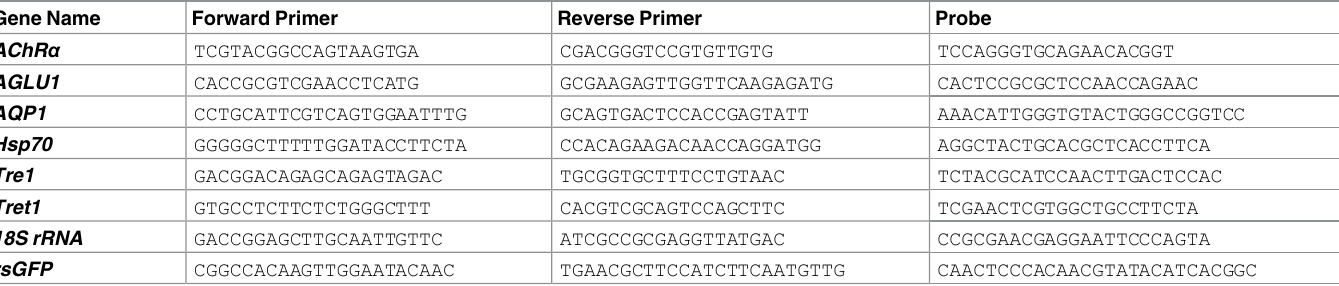
Table 2. Gene-specific quantitative PCR primer-probe